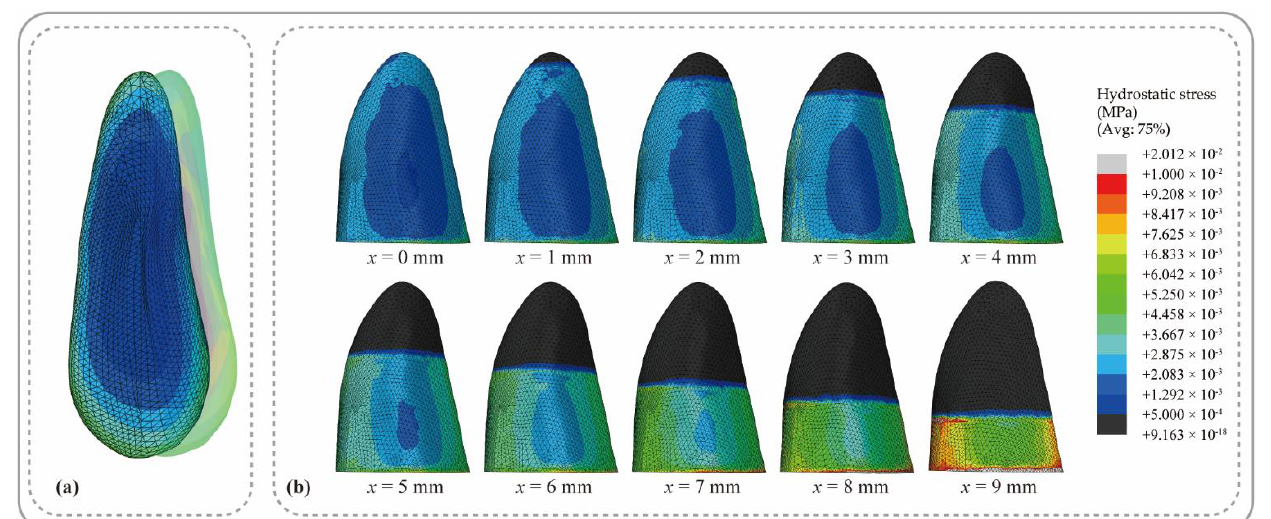
Figure 5. Simulation results of the stress distributions for different subjects of canine under a bodily movement. ( a ) The canine executes a bodily movement at the key increment of the simulation. ( b ) The hydrostatic stress distributions along PDL of canines with different penetration depth ( x ) during the bodily movement (labial view). PDL is the periodontal ligament.